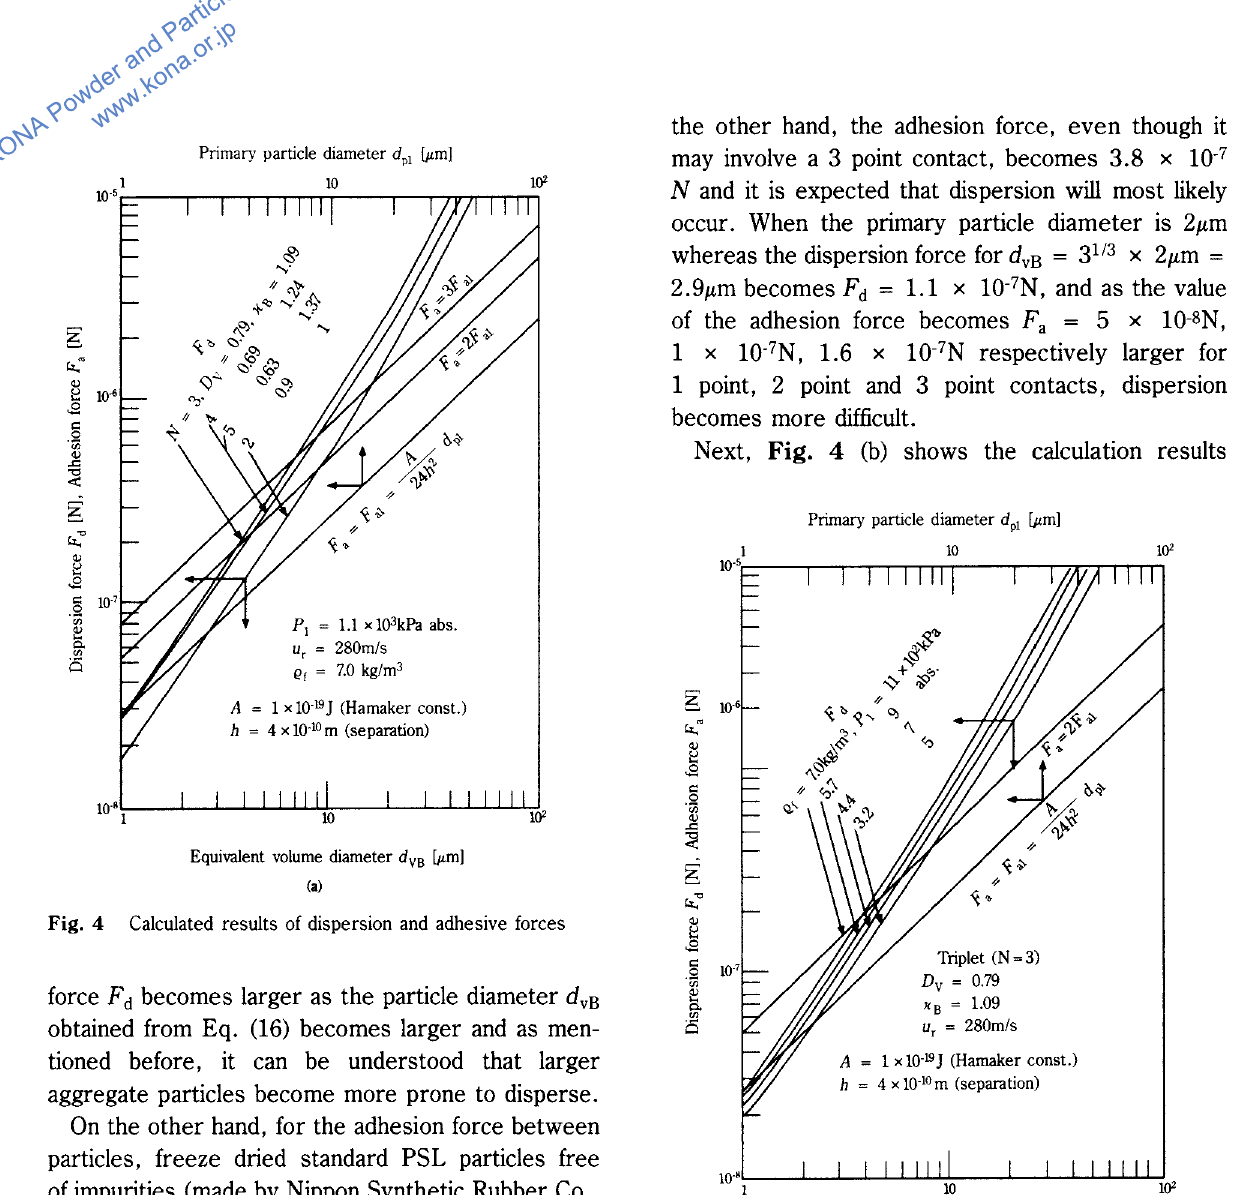
Calculated results of dispersion and adhesive forces